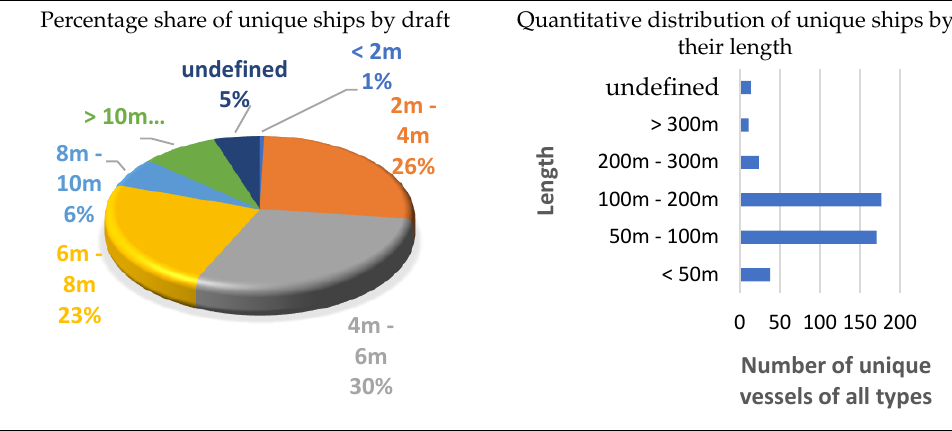
Table 11. List of ships on the2-2 measurement profile, broken down by type. Type of Vessel (Identifier No.)